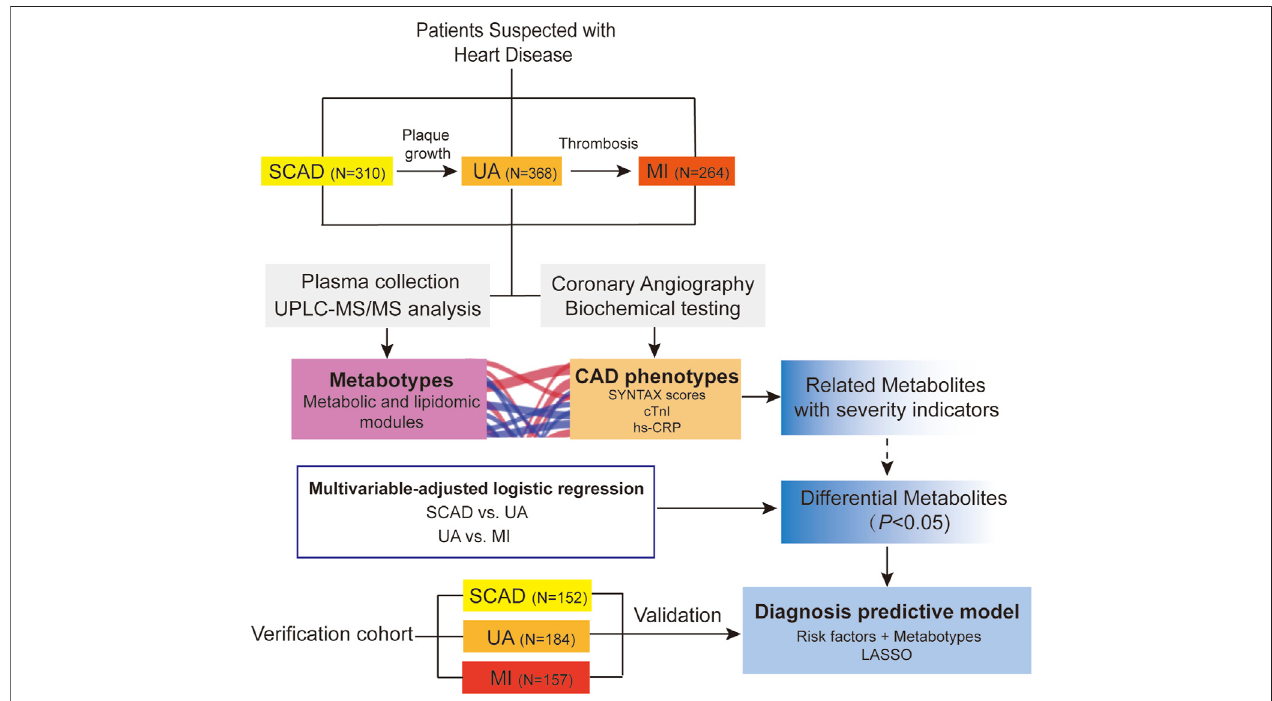
FIGURE1| Overviewofworkflowchartfordatagenerationandanalysis.CAD,coronaryarterydisease;cTnI,cardiactroponinI;hs-CRP,high-sensitivityC-reactive protein; LASSO, least absolute shrinkage and selection operator; MI, myocardial infarction; SCAD, stable coronary disease; UA, unstable angina; SYNTAX scores, SynergybetweenpercutaneouscoronaryinterventionwithTAXUSandCardiacSurgeryscores;UPLC-MS/MS,ultra-performanceliquidchromatography-tandemmass